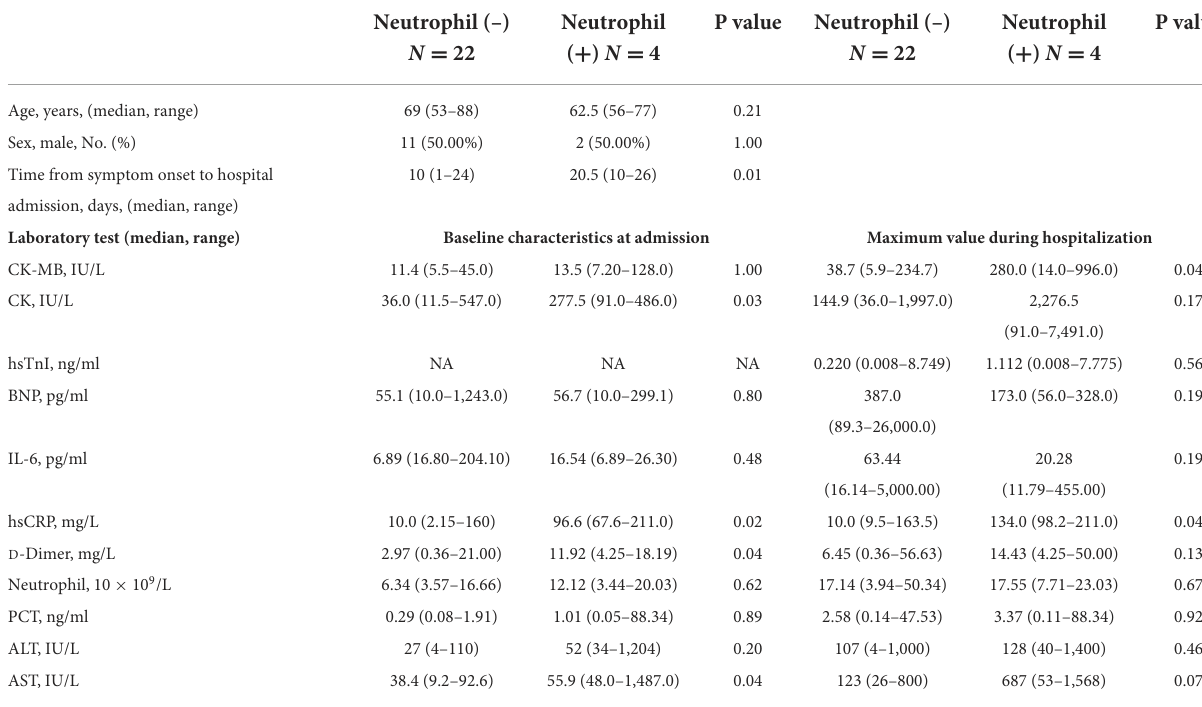
TABLE 2 Clinical characteristics of cases with vs. without neutrophil infiltration.